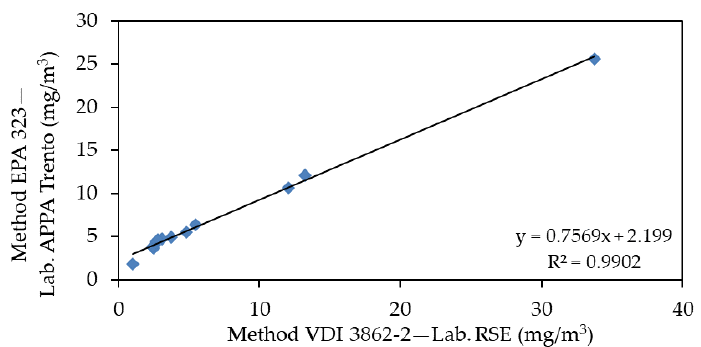
Figure 6. Correlation of same samples according to the VDI 3862-2 analyzed by Lab. APPA Trento and Lab. RSE during First Campaign.